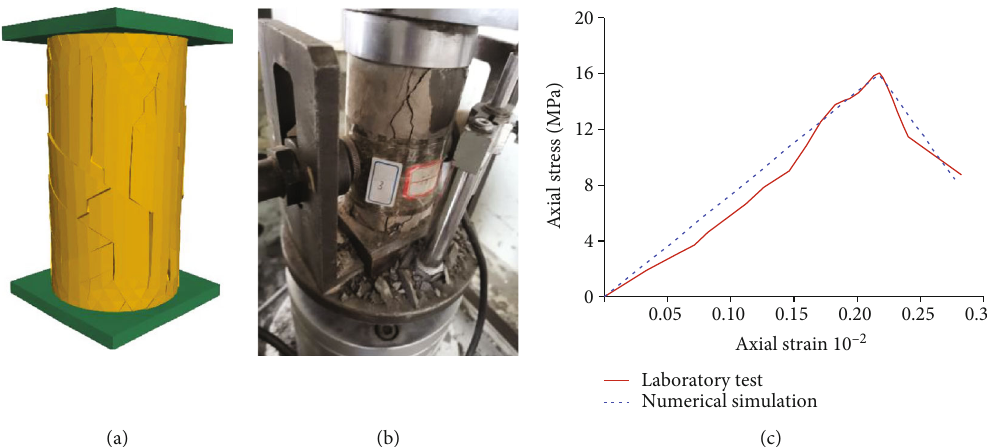
Figure 6: Check of uniaxial test. (a) Numerical model of uniaxial compression. (b) Uniaxial test in laboratory. (c) Uniaxial test curves of rocks.